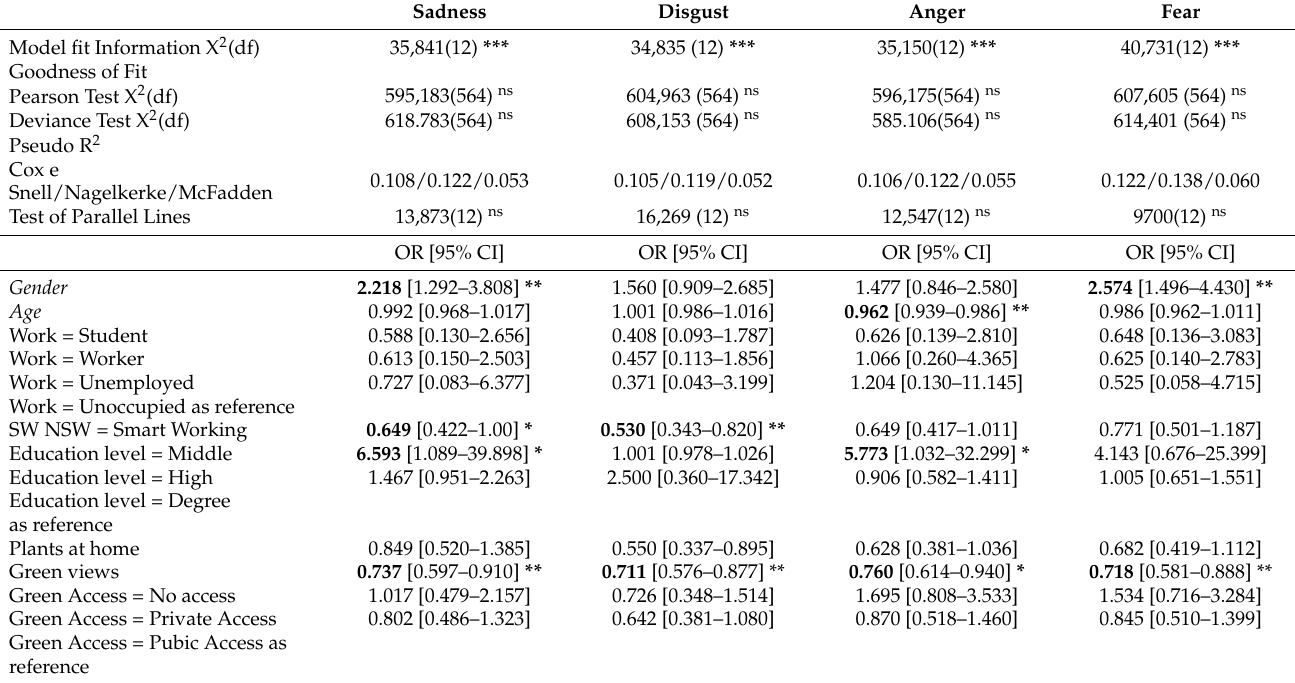
Table A1. Ordinal logistic models for the change in intensity level of each basic emotion.